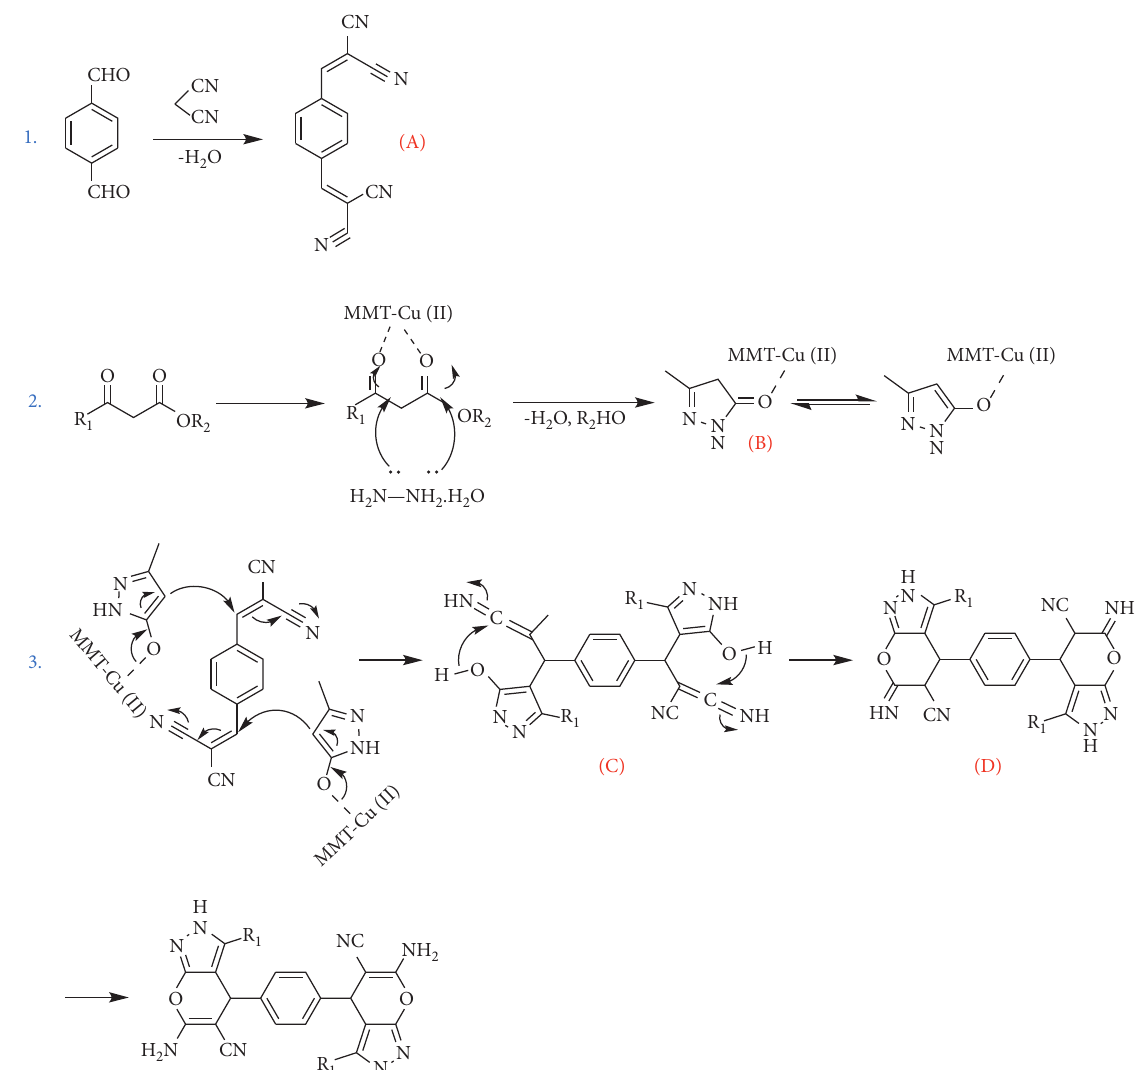
Scheme 3: Proposed mechanism for one-pot synthesis of bispyrano[2,3-c]pyrazoles by MMT-[(CH